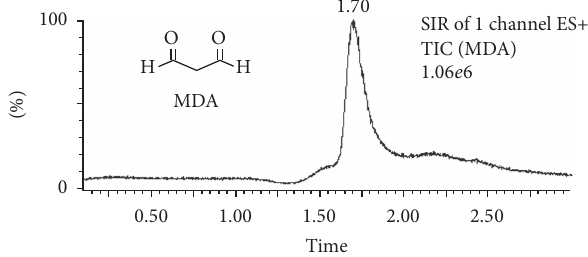
Figure 3: MDA chromatogram obtained with a UPLC C 18 column associated with (+)ESI-MS/MS after sample SPE treatment. The analyte was quantified using the selected ion monitoring (SIR)